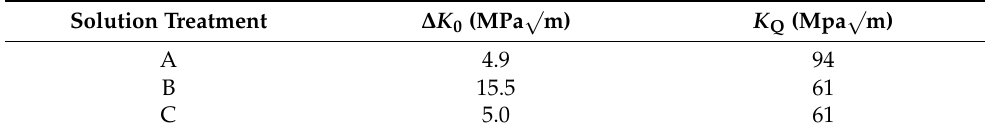
Table 4. ∆ K 0 and K Q for different solution treatment